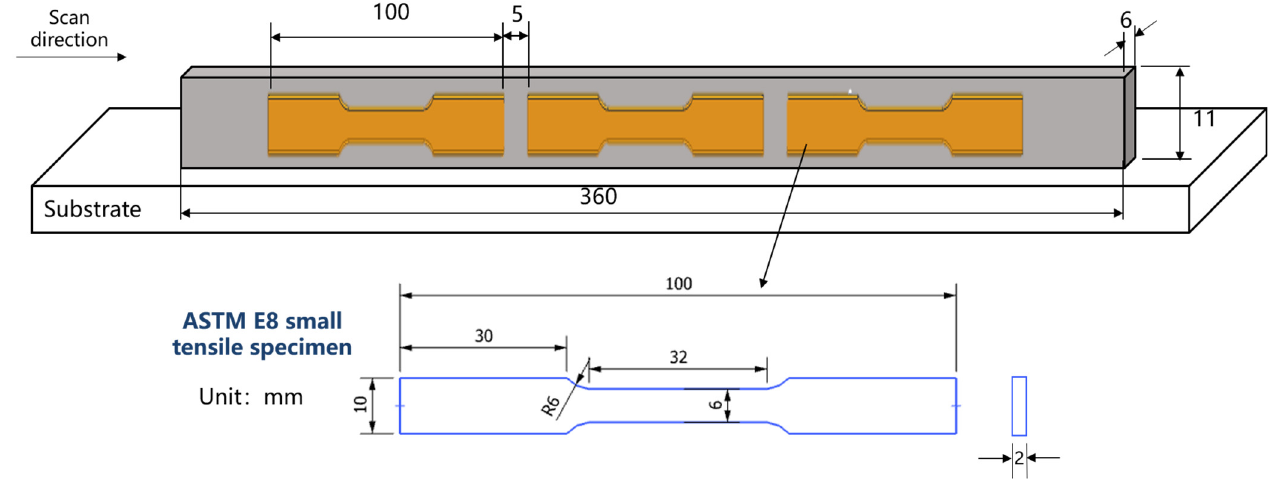
Figure 17. Schematic showing the fabricated component and samplings.